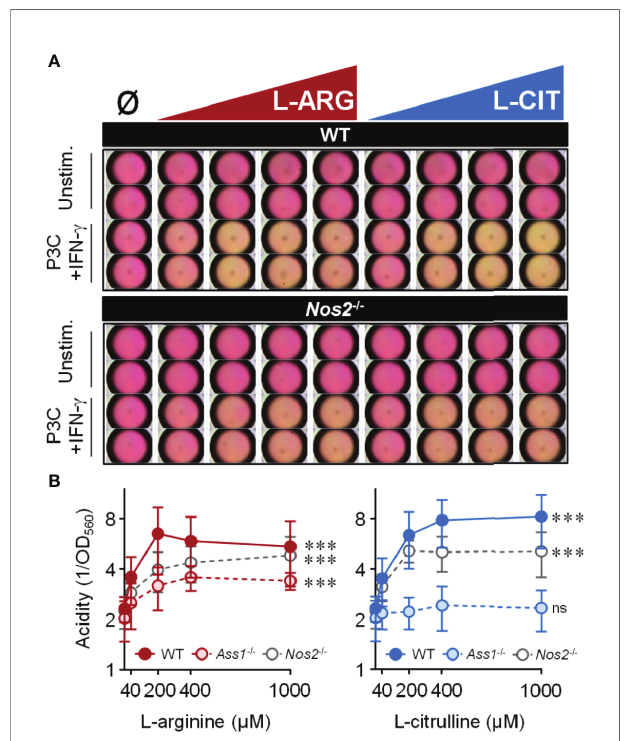
FIGURE 2 | Extracellular acidity increases in the presence of L-arginine/L- citrulline. PM F s were stimulated with Pam3Cys (P3C) plus IFN- g cultured in R-free C-DMEM containing titrating amounts of L-arginine (red) or L-citrulline (blue). (A) Representative images of media color 72 hours post-stimulation. (B) Relative acidity from Pam3Cys plus IFN- g stimulated PM F s (N ≥ 9, at least three experiments combined). ***p < 0.001, by 1-way ANOVA to determine any effect of L-arginine/L-citrulline on acid production; ns, not signi fi cant. Error bars,